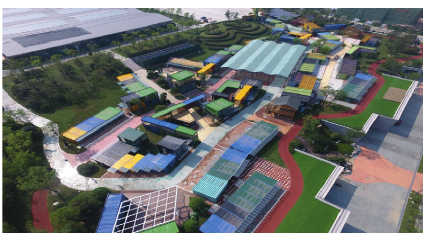
Figure 1: Pilot project-real aerial photo of Huaduhui Commercial